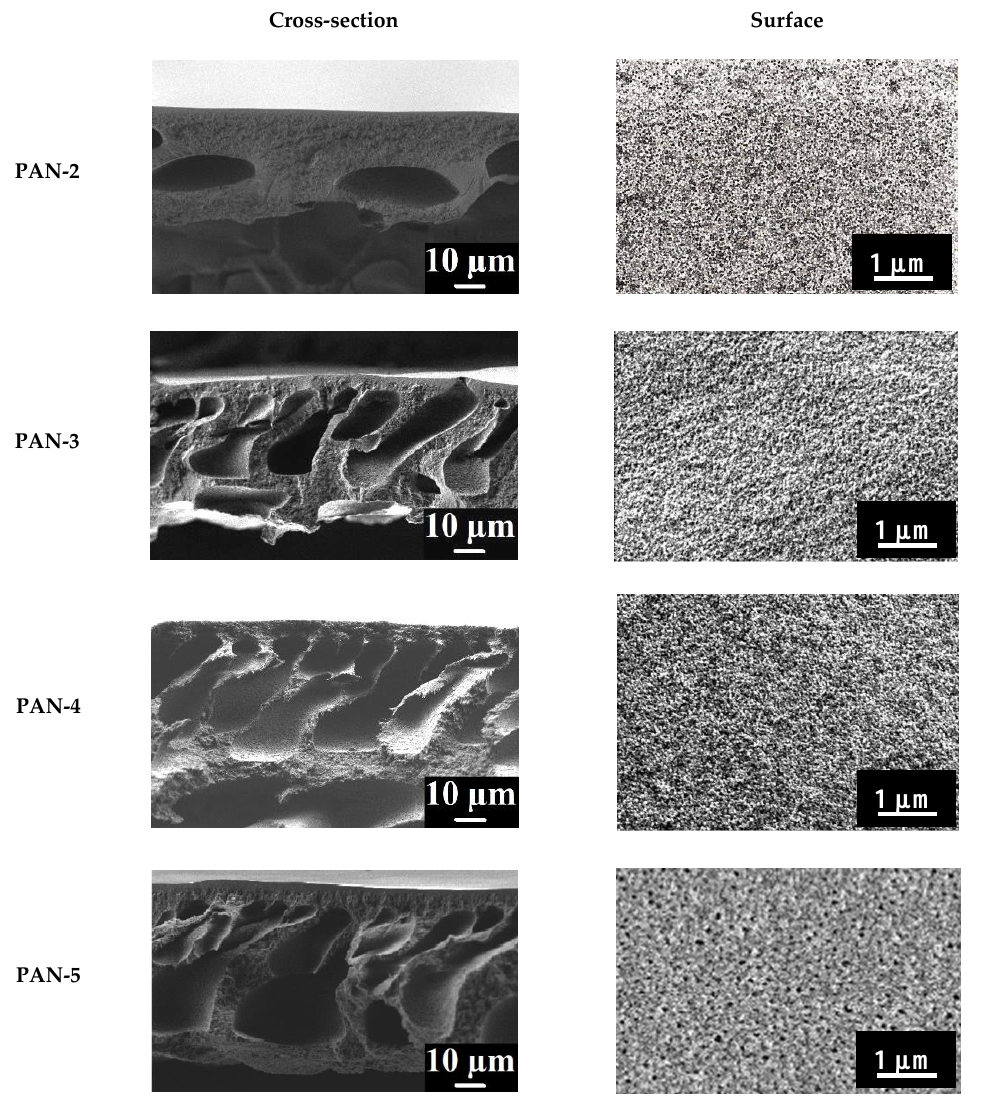
Figure 4. SEM micrographs of the cross-sections and surfaces of the selective layers of the porous PAN membranes (substrates).